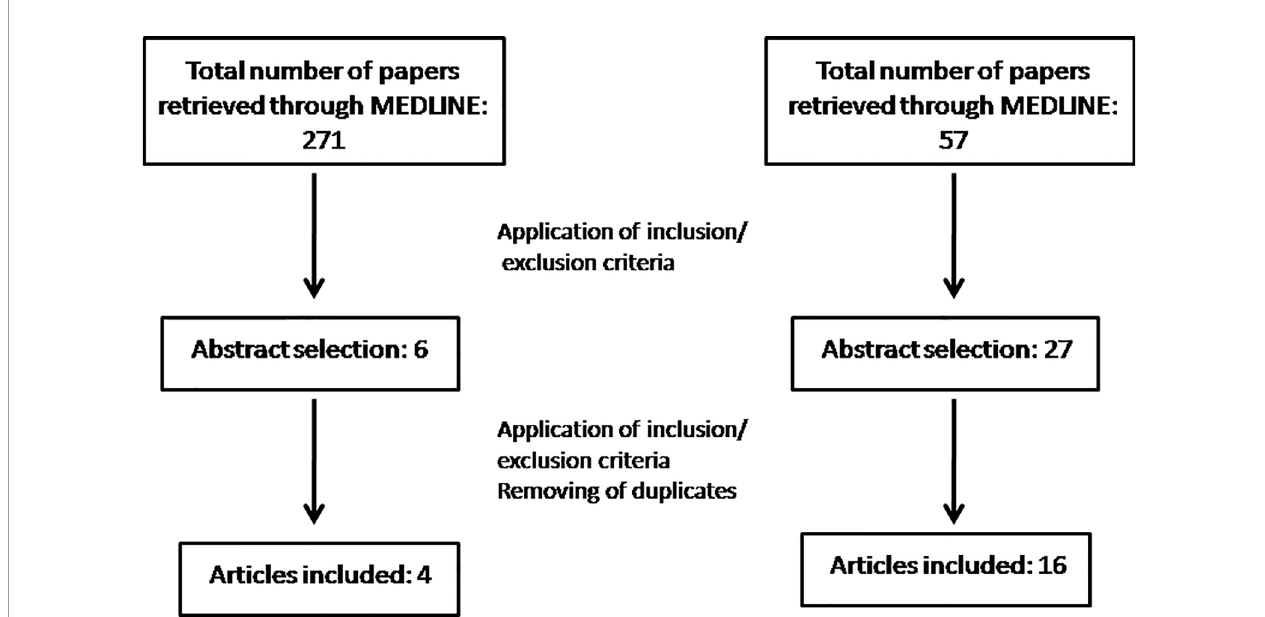
FIGURE 1 | Flow chart of in vitro and in vivo